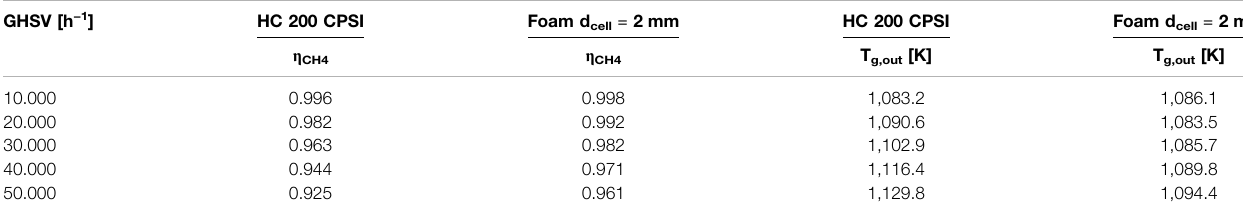
TABLE 6| Comparison of methane conversion and outlet gas temperature for thehoneycomb considered in Figure 4 , Figure 5A and the foam considered in Figure 7 and Figure 8A . GHSV [h − 1 ]